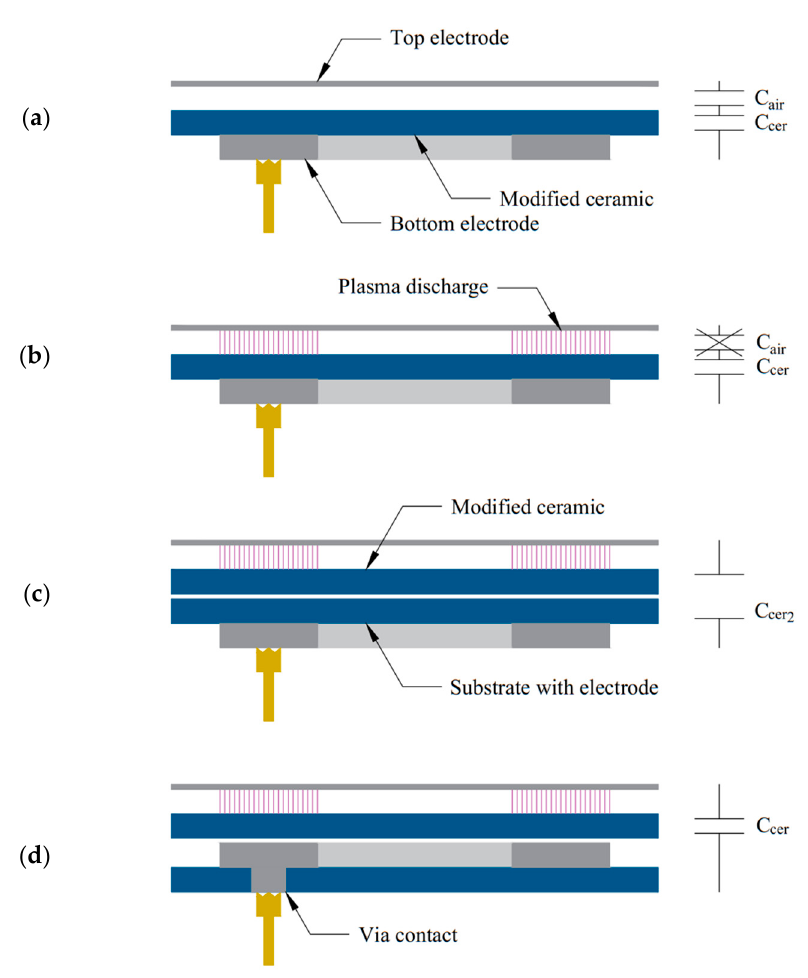
Figure 8. Selective dielectric barrier discharge (SDBD) set-ups for optimization of the electric field magnitude: ( a ) the bottom electrode deposited on the modified structure (capacitances before discharge occurrence); ( b ) air capacitance is broken during discharge; ( c ) for series manufacturing, the bottom electrode can be deposited on another substrate, although it increases capacitance during discharge, decreasing the magnitude of the electric field; ( d ) the bottom electrode can be deposited on top of the additional substrate to reduce additional capacitance, where contact is maintained through a via contact.